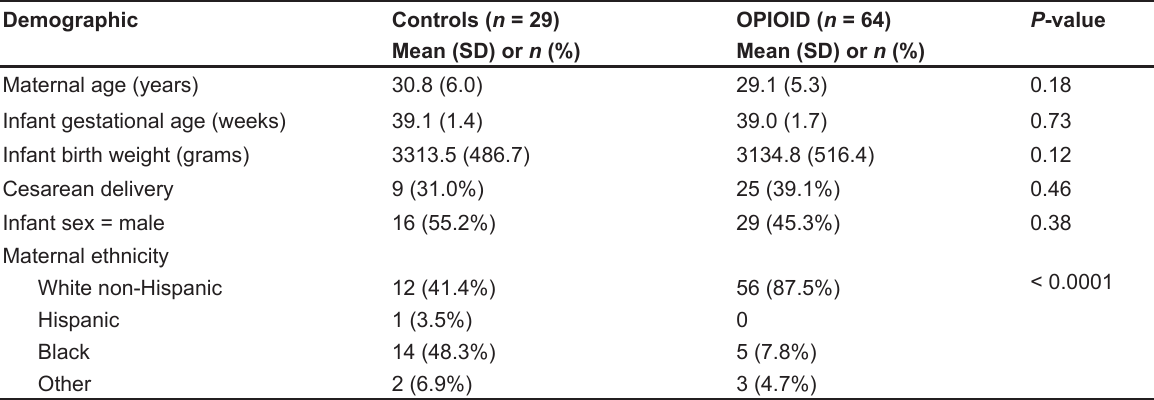
Table 1. Demographics of control and opioid mother-infant